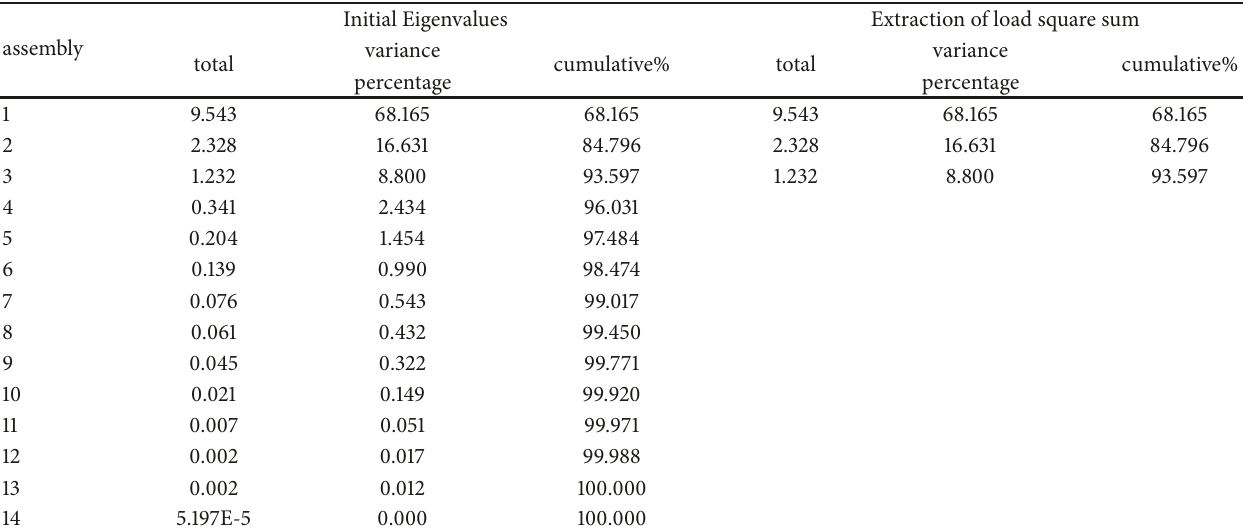
Table 5: Principal component characteristic root and contribution